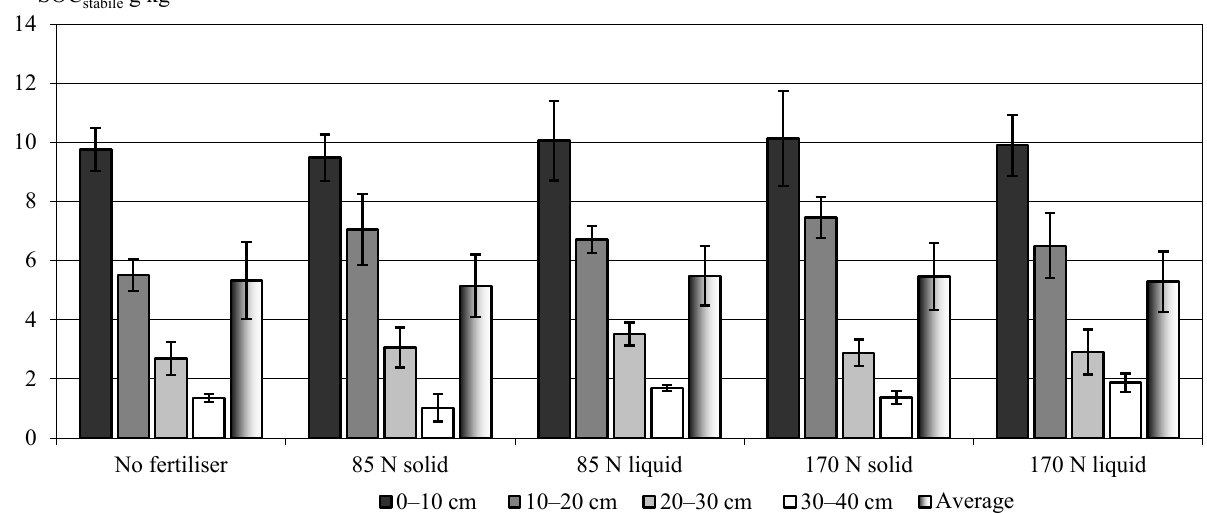
Figure 3. Stabile soil organic carbon (SOC stabile ) in grassland soil treated by digestate, 2019. Vertical bars represent standard error.